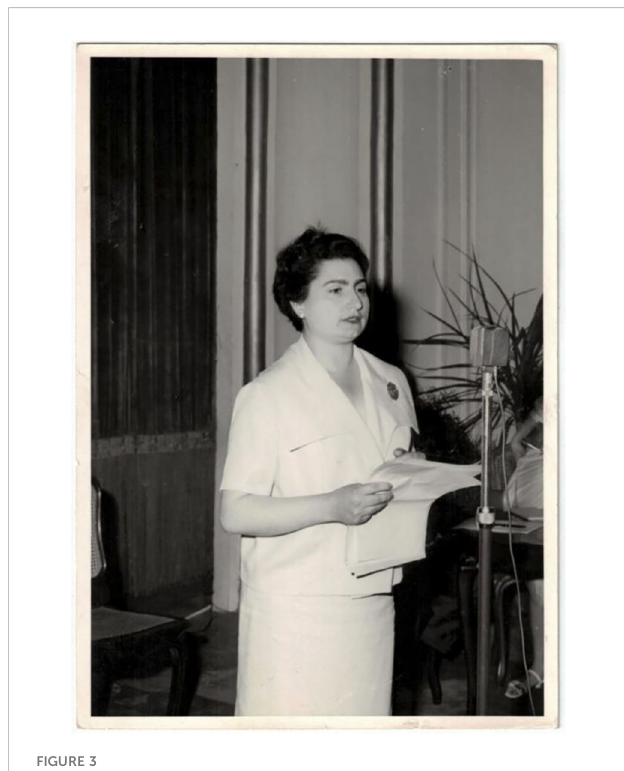
FIGURE 3 Jole Ceruti Scurti presenting her work at a phytopathological Congress in